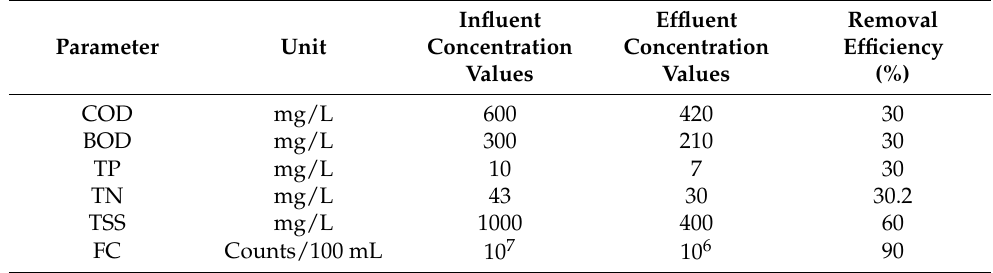
Table 1. Influent and effluent pollutants concentrations during primary sedimentation